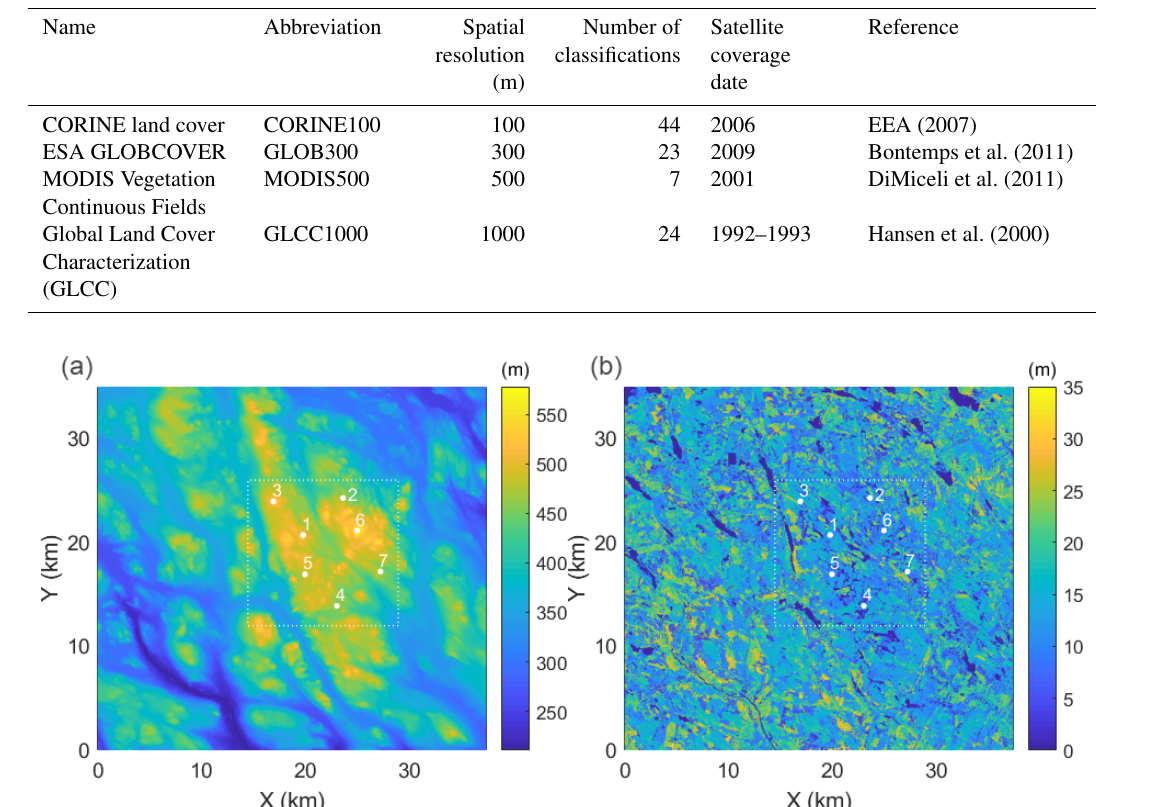
Figure 1. Terrain (a) and tree height (b) maps of the site derived from airborne laser scans with a 20m resolution. The dashed rectangle indicates the area covered in Fig. 2, and the numbered points show the locations of the seven masts.